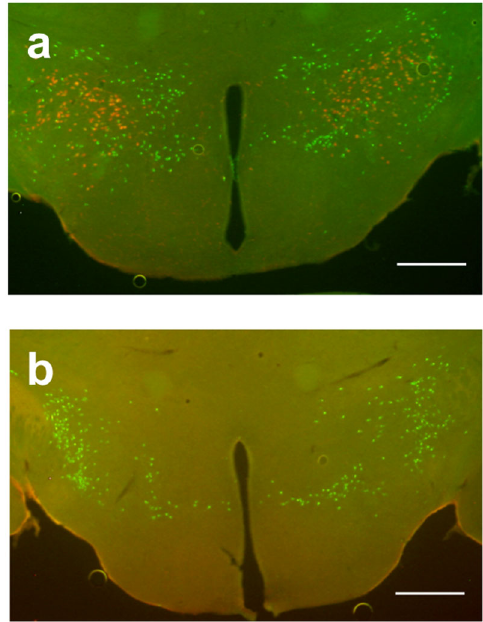
Fig. 4 Localization of orexin and MCH-positive cells in the hypothalamus. a Typical photograph of the hypothalamus of a wild-type mouse showing the distribution of orexin-positive cells (red) and melanin concentrating hormone (MCH)-positive cells (green). b Typical photograph from ORX-AB mouse showing there are no longer any orexin-positive cells. Scale bar: 500 µ